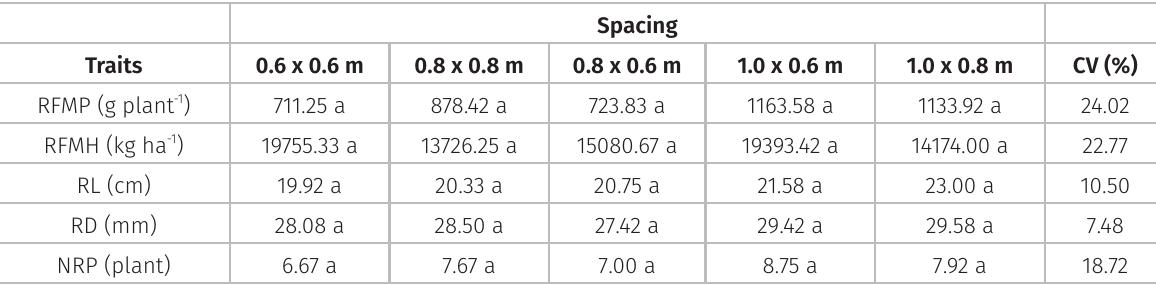
Table IV. Root fresh matter per plant RFMP (g plant −1 ) and hectare (RFMH, kg ha −1 ), root length (RL), root diameter (RD), and number of roots per plant (NRP) in cassava plants at spacings of 0.6 × 0.6, 0.8 × 0.8, 0.8 × 0.6, 1.0 × 0.6, and 1.0 × 0.8